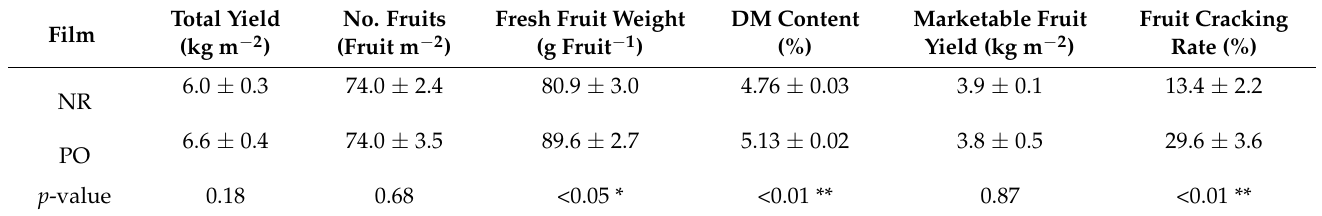
Table 1. Effects of high tunnel-covering film on total yield, number of fruits, fresh fruit weight, dry matter (DM) content, marketable fruit yield, and fruit cracking rate.